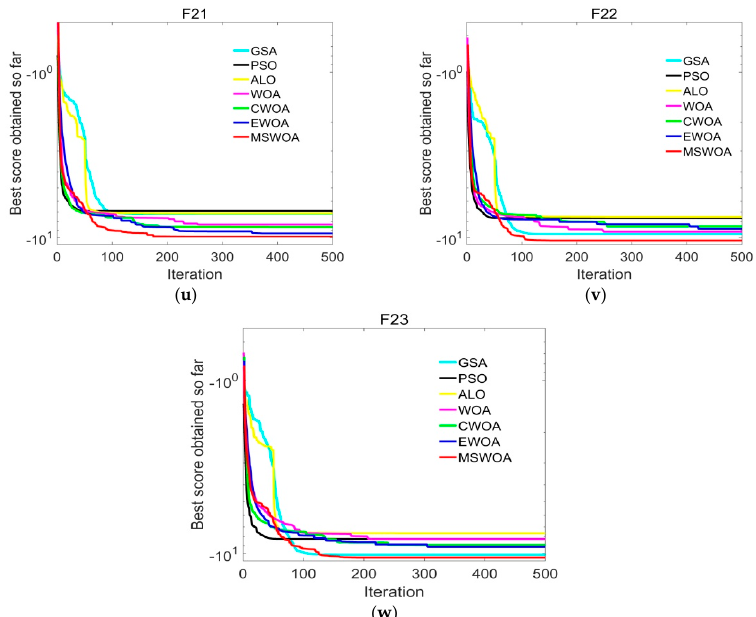
Figure 4. Comparison of average iteration process of seven different algorithms for 23 benchmark functions. ( a ) Curves of the fitness values for F1; ( b ) Curves of the fitness values for F2; ( c ) Curves of the fitness values for F3; ( d ) Curves of the fitness values for F4; ( e ) Curves of the fitness values for F5; ( f ) Curves of the fitness values for F6; ( g ) Curves of the fitness values for F7; ( h ) Curves of the fitness values for F8; ( i ) Curves of the fitness values for F9; ( j ) Curves of the fitness values for F10; ( k ) Curves of the fitness values for F11; ( l ) Curves of the fitness values for F12; ( m ) Curves of the fitness values for F13; ( n ) Curves of the fitness values for F14; ( o ) Curves of the fitness values for F15; ( p ) Curves of the fitness values for F16; ( q ) Curves of the fitness values for F17; ( r ) Curves of the fitness values for F18; ( s ) Curves of the fitness values for F19; ( t ) Curves of the fitness values for F20; ( u ) Curves of the fitness values for F21; ( v ) Curves of the fitness values for F22; ( w ) Curves of the fitness values for F23.